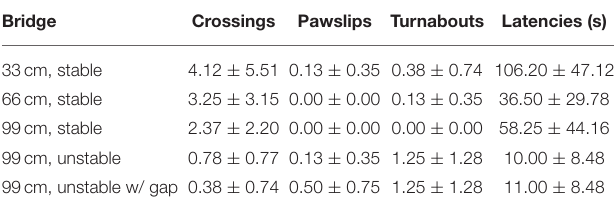
TABLE 1 | Mean ( ± SEM) number of the performances on the different bridges in Group 1 (WT rats grown up with DAT trunk rats). Bridge Crossings Pawslips Turnabouts Latencies (s)